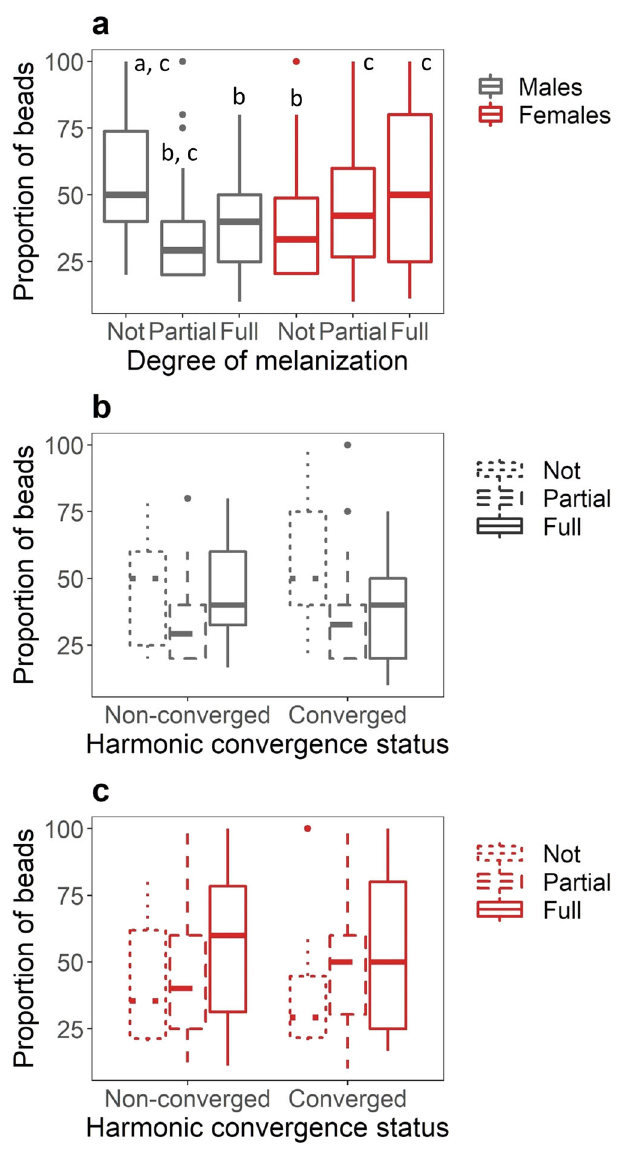
Fig. 1 The effect of sex and harmonic convergence on melanization ability. The mean proportion of beads that were unmelanized (Not), partially melanized (Partial), or fully melanized (Full) 24h after individual Aedes aegypti were injected with a single, neutrally charged G25 Sephadex bead and housed at 27°C ( n = 641 observations). Boxes are boxplots of the interquartile range with medians for each treatment group, whiskers represent the fi rst and third quartiles, and points are outliers in the data. Male and female mosquitoes are colored gray and red, respectively. a Main effect of sex on melanization ability. Letters denote signi fi cant differences among treatment groups ( p <0.05) determined by Tukey ’ s contrasts. b The effect of parental convergence status (non-converged vs. converged) on melanization ability in male mosquitoes. c The effect of parental convergence status on melanization ability in female mosquitoes. In both b and c unmelanized, partially melanized, and fully melanized beads are represented by dotted, hashed, and solid lines,